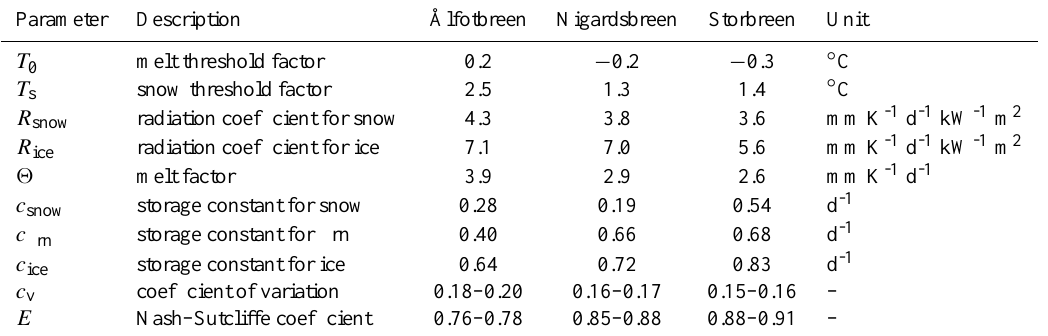
Table 3. Median of the 100 best parameter sets and model performance (coefficients of variation for seasonal mass balances and the Nash– Sutcliffe coefficient for daily discharge sums) of the 100 best ensemble runs for the calibration periods.